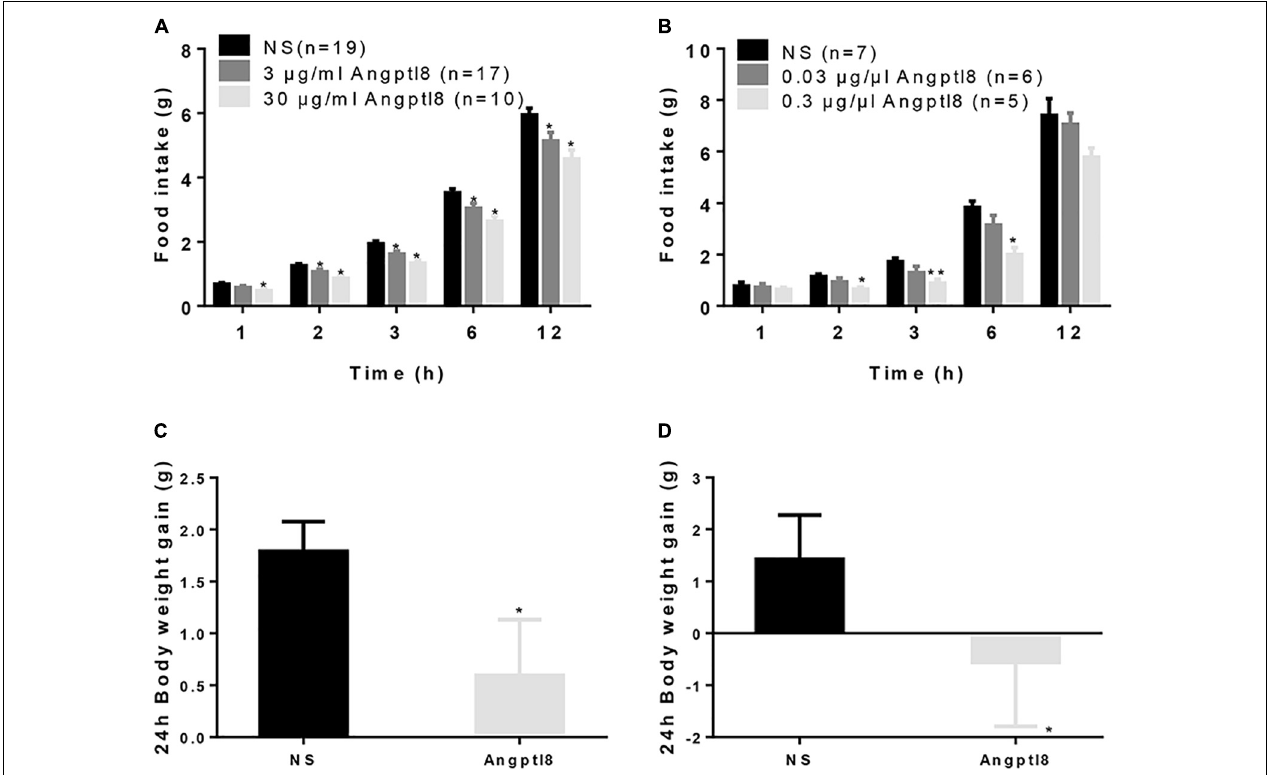
FIGURE 1 | Effect of peripheral and central Angptl8 on food intake and 24 h body weight. (A) After 12-h food deprivation, the I.V. injection of Angptl8 (0.1 ml) decreased nocturnal cumulative food intake from 1 to 12 h after injection. (B) After 12-h food deprivation, I.C.V. injection of Angptl8 (2 µ l) decreased nocturnal cumulative food intake from 2 to 6 h after injection. (C) Peripheral Angptl8 (0.1 ml; 30 µ g/ml) decreased 24-h body weight gain ( n = 8). (D) Central Angptl8 for (2 µ l; 0.3 µ g/ µ l) decreased 24-h body weight gain ( n = 6). Data are means ± SEM. ∗ P < 0.05 and ∗∗ P < 0.05 relative to the NS